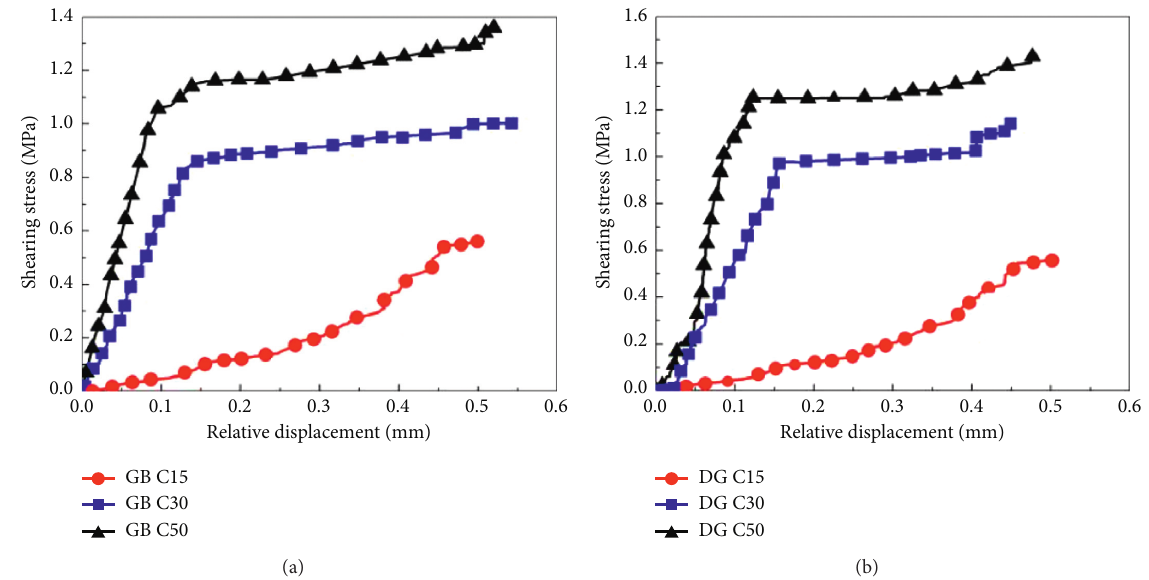
Figure 7: Relationship of the shearing stress over the relative displacement of the interface: (a) GB and (b) DG. Table 8: Maximum strain of the interface at failure for composite samples with different cement plates and concretes. Cement plate